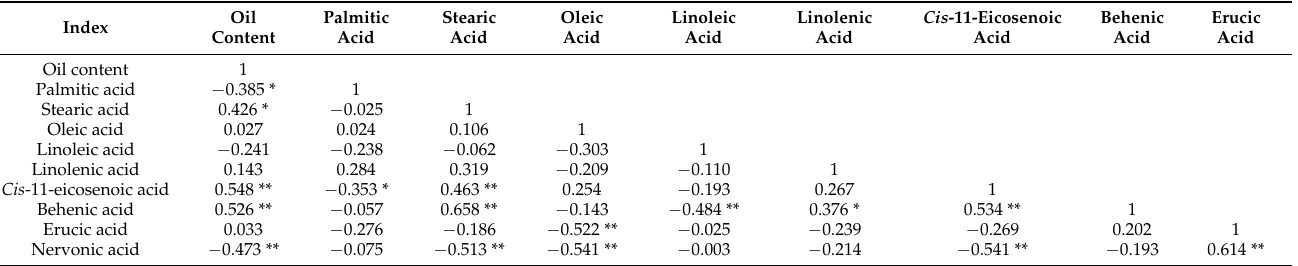
Table 5. Correlation between kernel oil content and fatty acids of A. truncatum from different